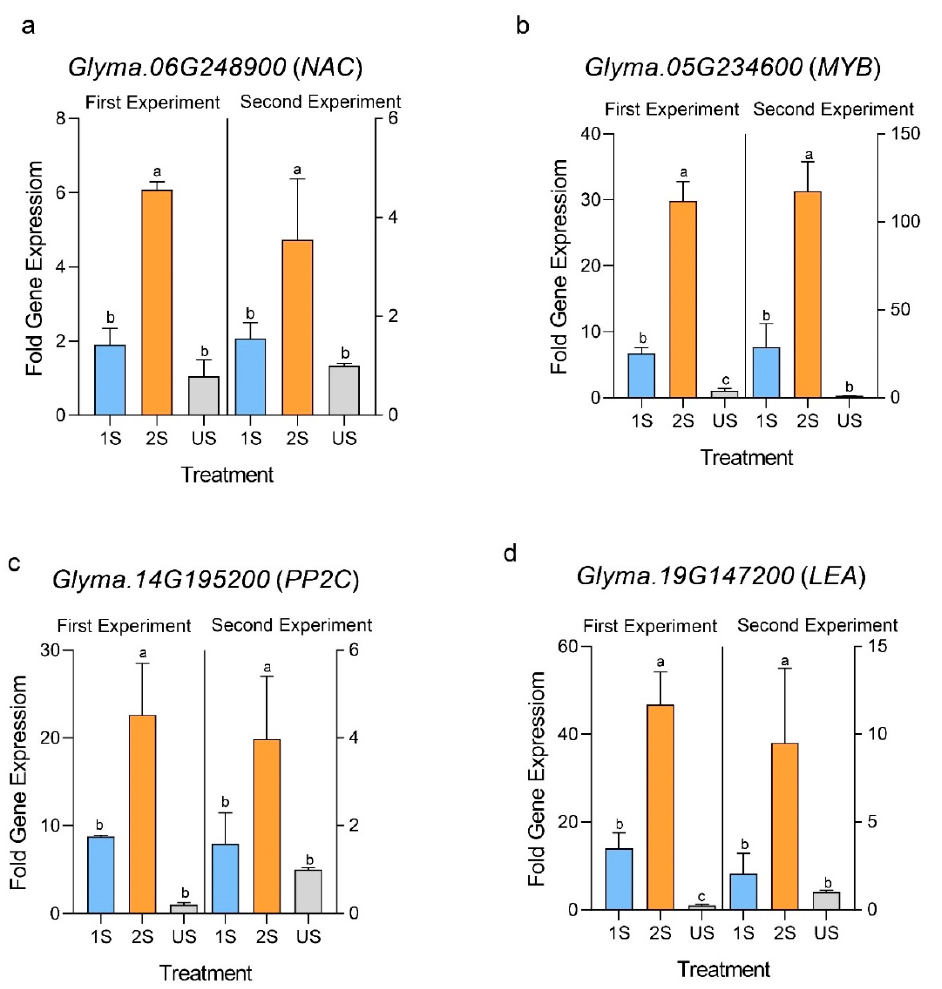
Figure 6. The relative expression levels of selected genes in primed (2S) and unprimed (1S) soybean C08 plants under drought treatment and the unstressed control (US) were analyzed by RT-qPCR. ( a ) Expression of Glyma.06G248900, ( b ) Glyma.05G234600, ( c ) Glyma.14G195200, and ( d ) Glyma.19G147200 was calculated by 2 −ΔΔ CT method. The data are presented as the mean of three technical replicates ± SD. Tukey’s honest significance test was used to compare between the mean values of each treatment following one-way ANOVA. Different letters above the bars indicate significant differences between groups at p < 0.05. act11 and elf1b were used as the reference genes. The scale on the left y -axis refers to the data from the first experiments and that on the right y -axis refers to those from the second